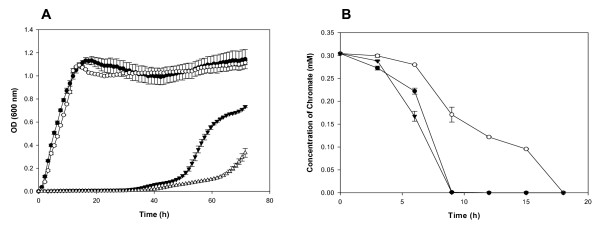
Growth and chromate reduction kinetics of S. oneidensis MR-1 wild type and the Δso2426 mutant. (A) Wild-type (●) and mutant (○) cultures were cultivated in LB broth without the addition of chromate under aerobic conditions and compared to wild-type (▼) and mutant (△) cultures grown in LB broth amended with a final K2CrO4 concentration of 0.3 mM. (B) Cr(VI) removal rates for the S. oneidensis MR-1 (●), Δso2426 (○), and complemented Δso2426(so2426+) (▼) strains in LB broth supplemented with 0.3 mM chromate. The different cultures were challenged with 0.3 mM K2CrO4 when cells reached an OD600 of 0.5 (mid-log point). The error bars indicate standard deviations of triplicate measurements.